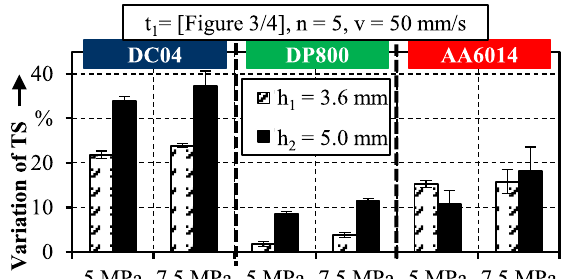
Fig. 12. Percentage modi fi cation of fracture strain in tensile tests after preloading in a drawbead passage h 2 = 5.0mm.